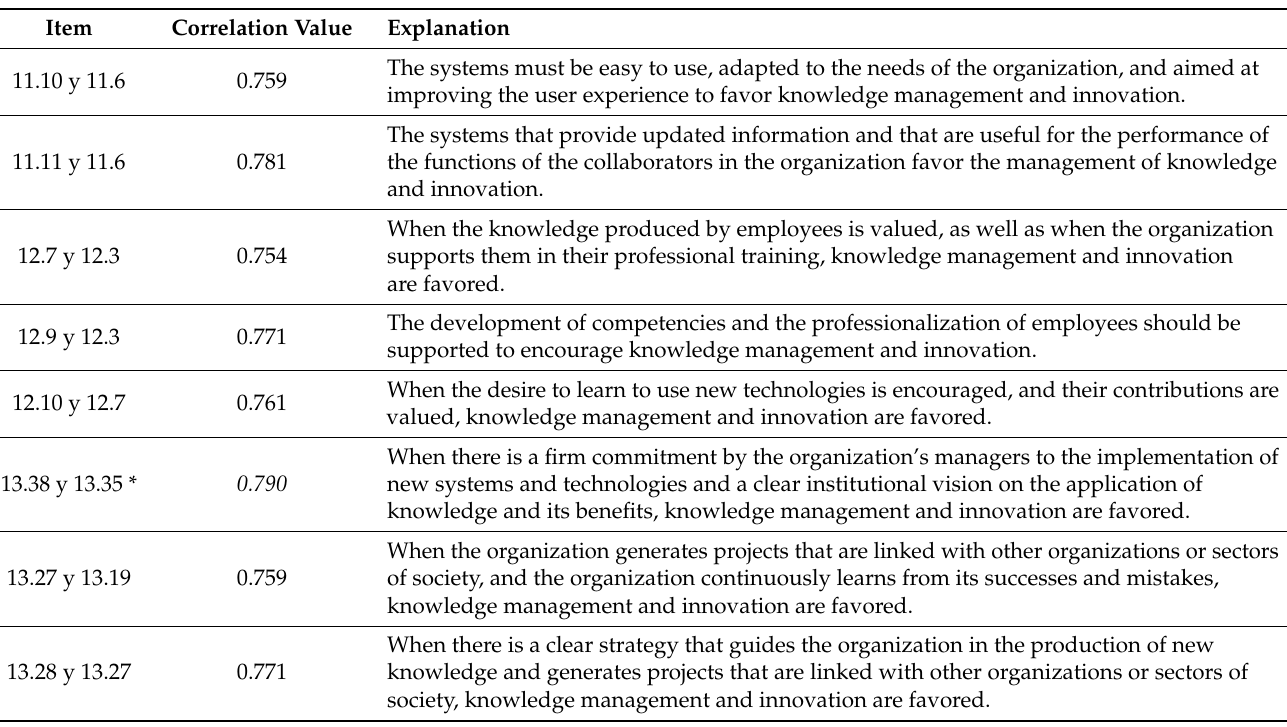
Table 5. Correlation